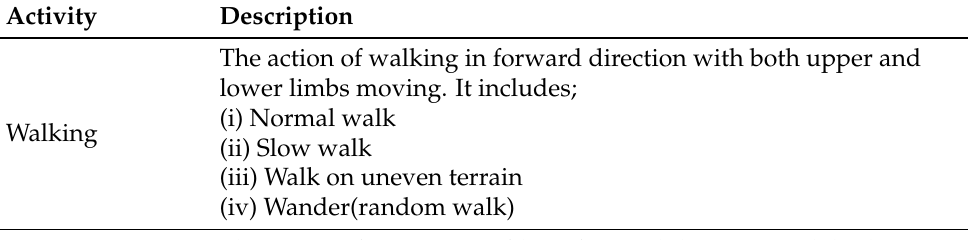
Table 1. Seven human